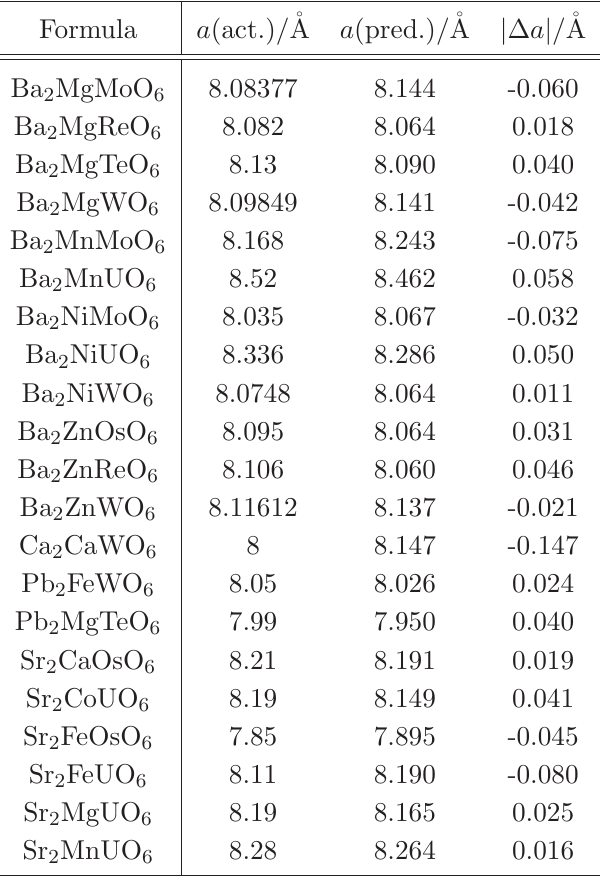
Table 3 (continue) Actual, predicted values for the unit cell length, as well as, absolute errors for the compounds of the calibration set obtained by